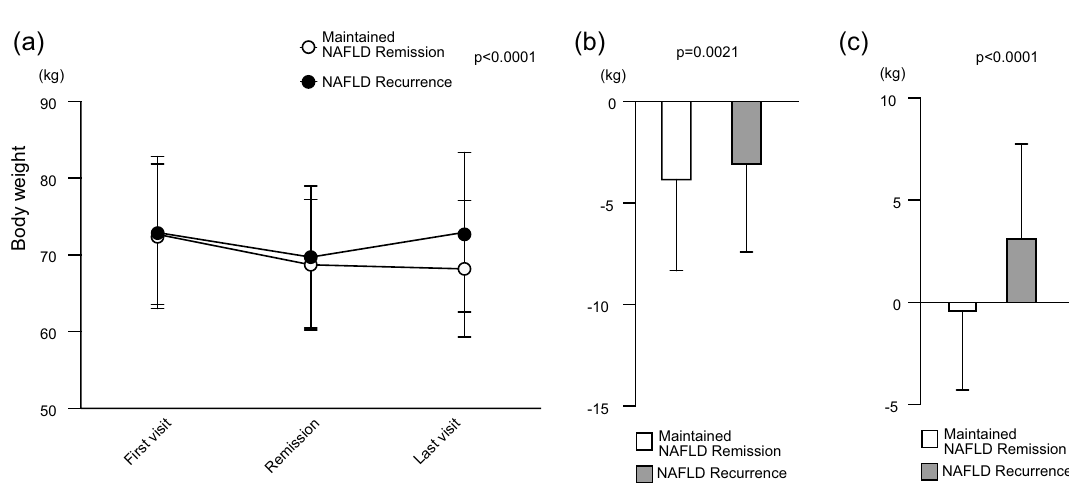
Figure 2. Body weight change in each group during the observation period. Data are shown as mean ± SD. ( a ) Changes in body weight. The p value was calculated using two-way repeated-measures analysis of variance. ( b ) Amount of weight change between the first visit and the date of NAFLD remission. The p value was calculated using Student’s t test. ( c ) Amount of weight change between the date of NAFLD remission and the last visit. The p value was calculated using Student’s t test. NAFLD, nonalcoholic fatty liver and -3.2 ± 4.3 kg in the NAFLD recurrence group ( p = 0.0021) (Fig. 2b). Between the date of NAFLD remission and the last visit, however, a further body weight reduction of -0.5 ± 3.9 kg was observed in the maintained NAFLD remission group, while a weight regain of + 3.2 ± 4.6 kg was observed in the NAFLD recurrence group ( p < 0.0001) (Fig. 2c).